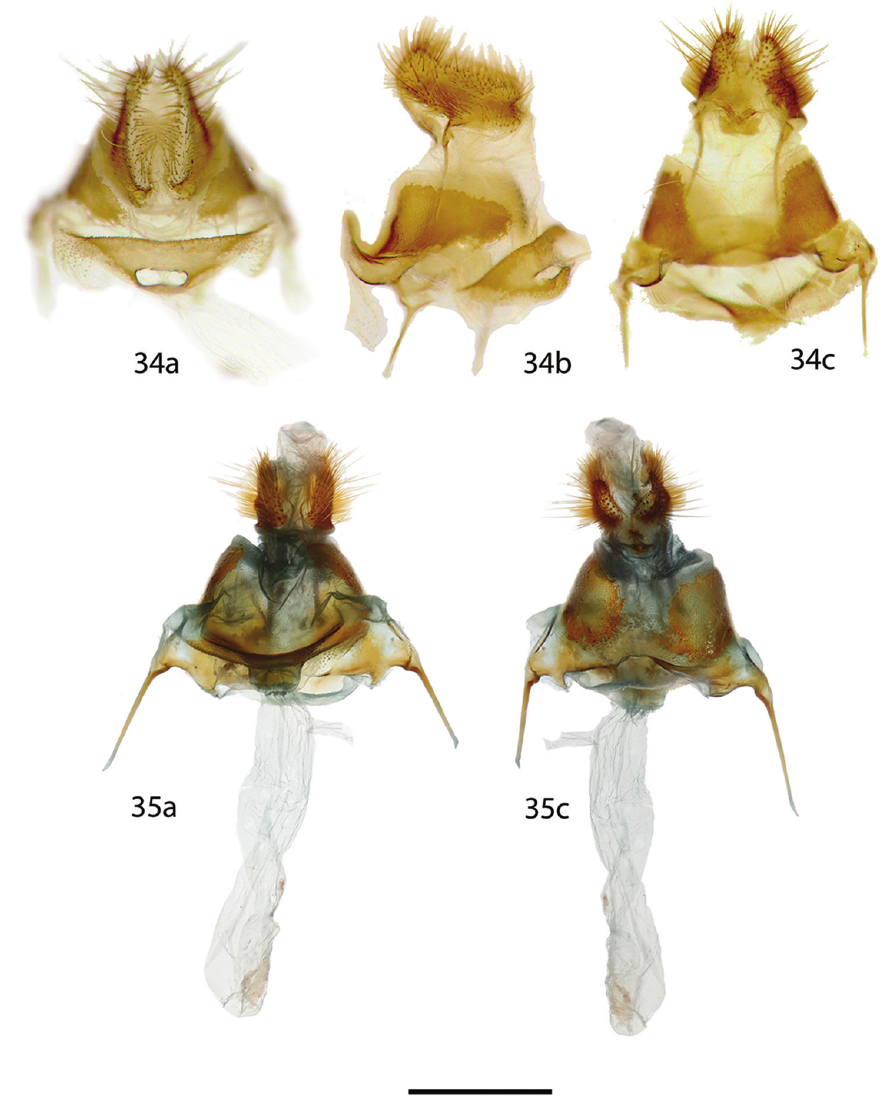
Figures 34, 35. Reinmara ignea female genitalia, a ventral b lateral c dorsal. 34 Holotype ♀ , Brazil, São Bento do Sul, Rio Natal, 550 m, C. Mielke genitalia prep. 20.982 (DZUP) 35 Paratype ♀ , Brazil, Rio de Janeiro, Nova Friburgo, 1100 m, St Laurent diss.: 2-29-16:1 (USNM). Note: different orientation of two preparations obfuscates their actual similarity, in Fig. 34a the lamella ante- and postvaginalis are pressed downward. Scale bar: 1